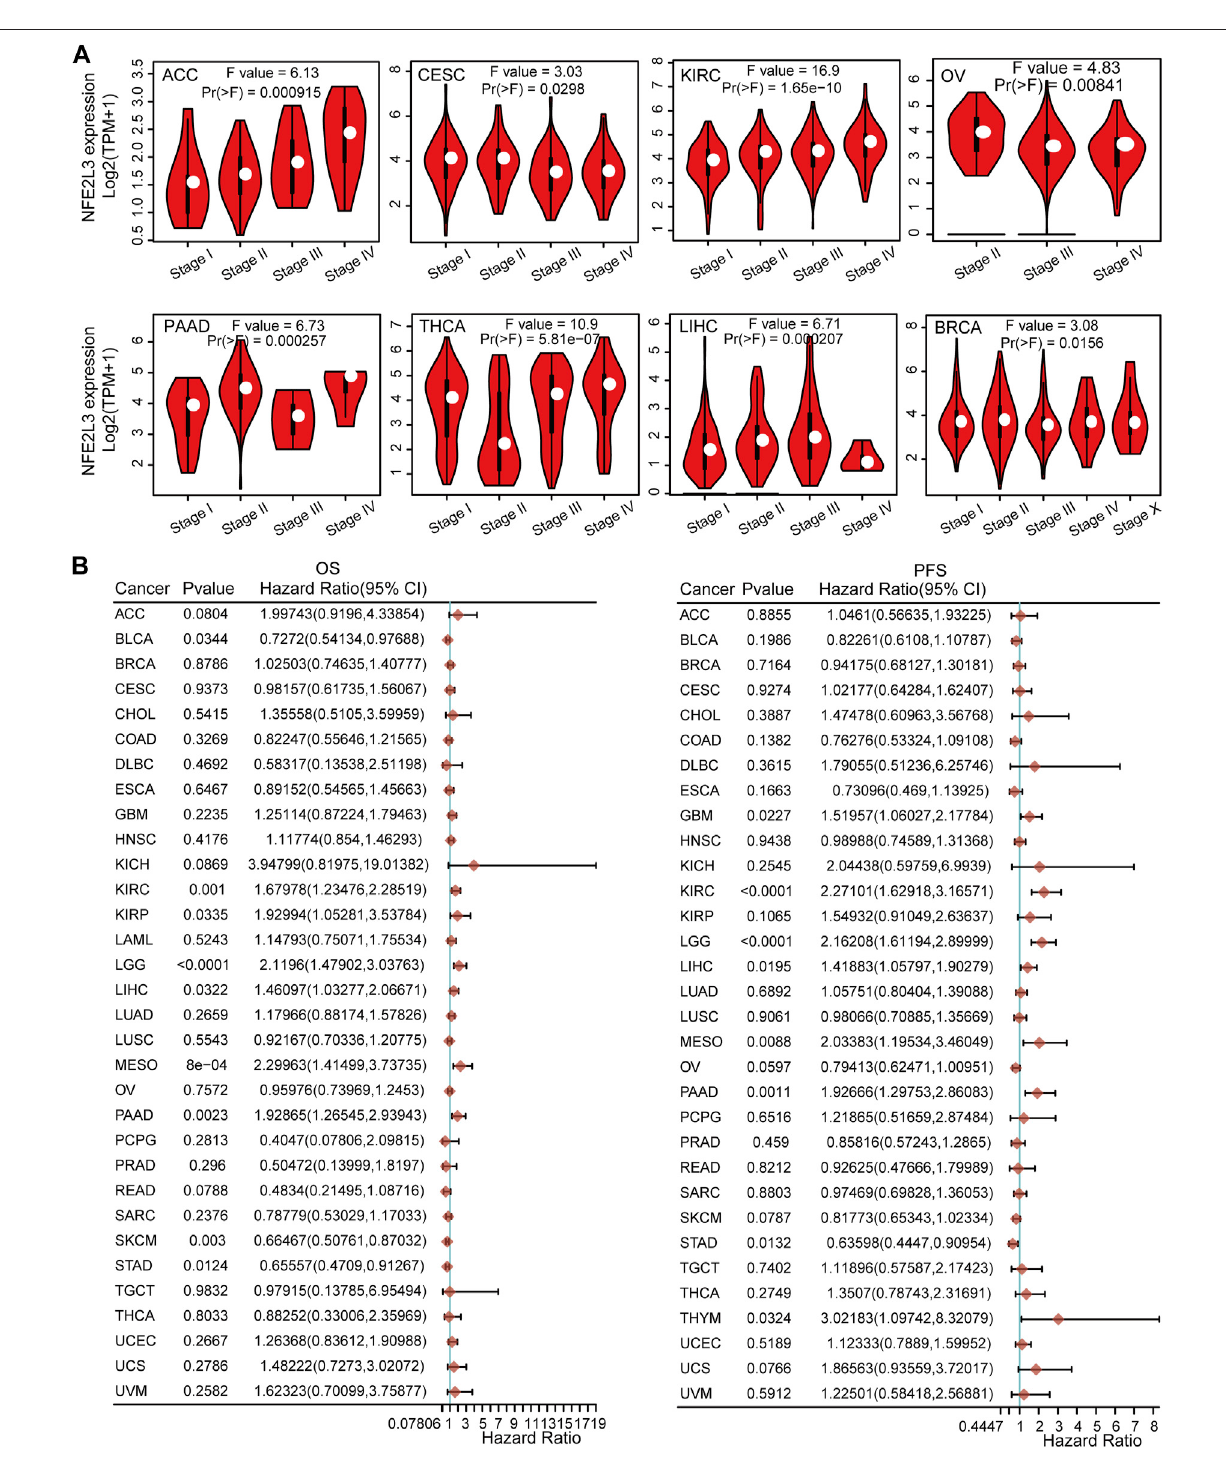
Frontiers in Genetics |